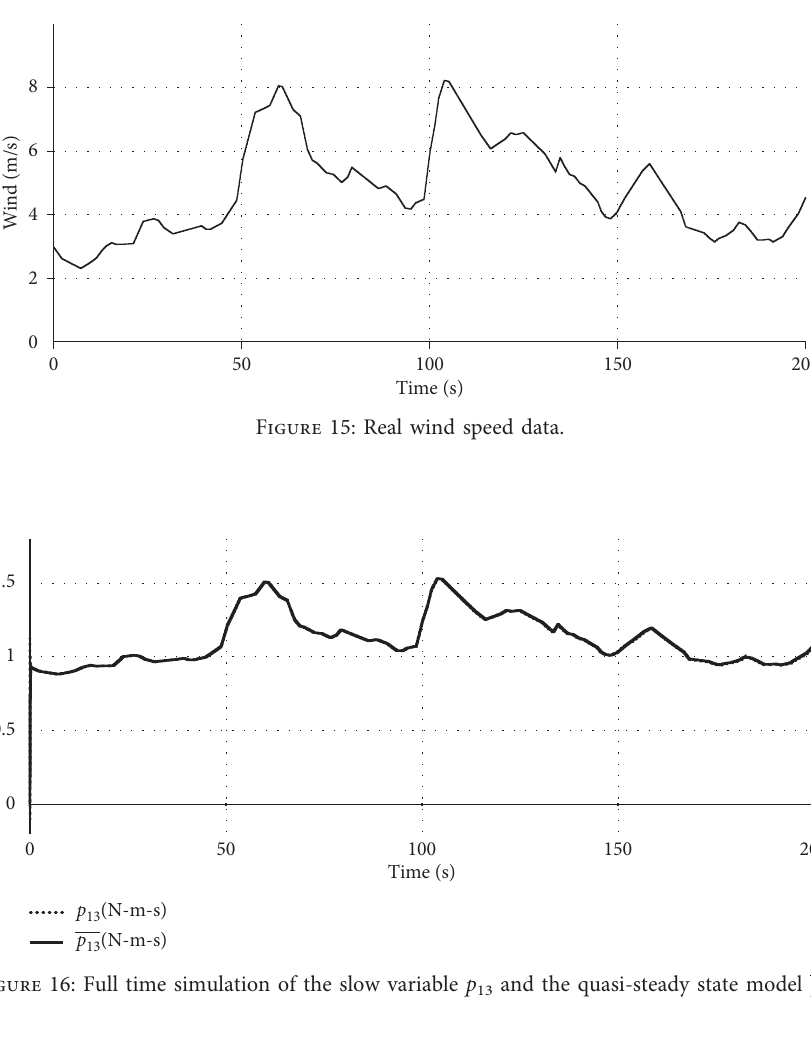
13 and the quasi-steady state model